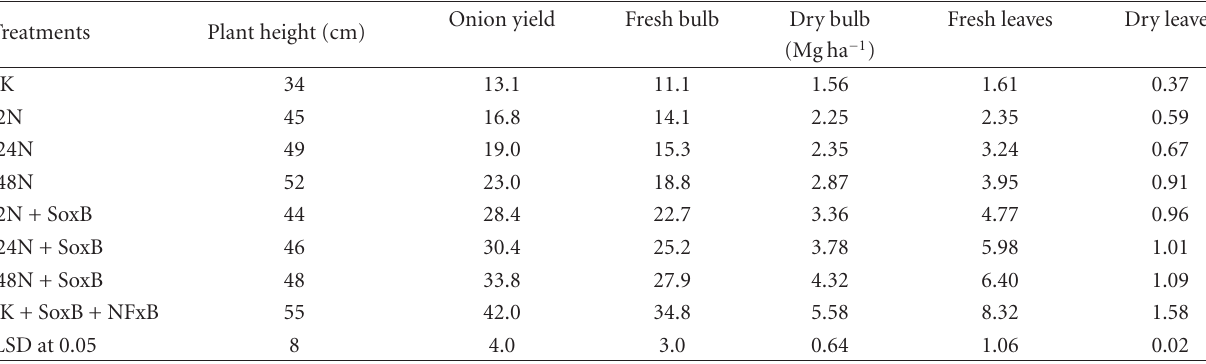
Table 1: E ff ects of di ff erent rates of nitrogen (kg ha − 1 ) without or with inoculation of sulfur-oxidizing bacteria (SoxB) and soil inoculated with SoxB and N-fixing Bacteria (NFxB) on onion plant growth parameters and bulb yield.